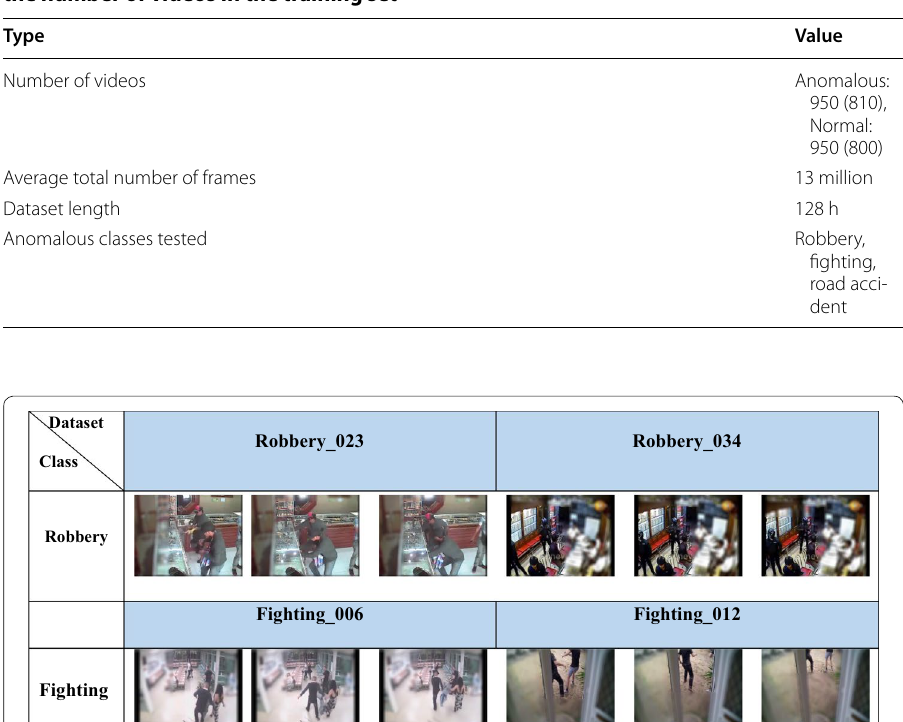
Table 2 Statistics about the localized UCF-crime dataset. Number in brackets represent the number of videos in the training set